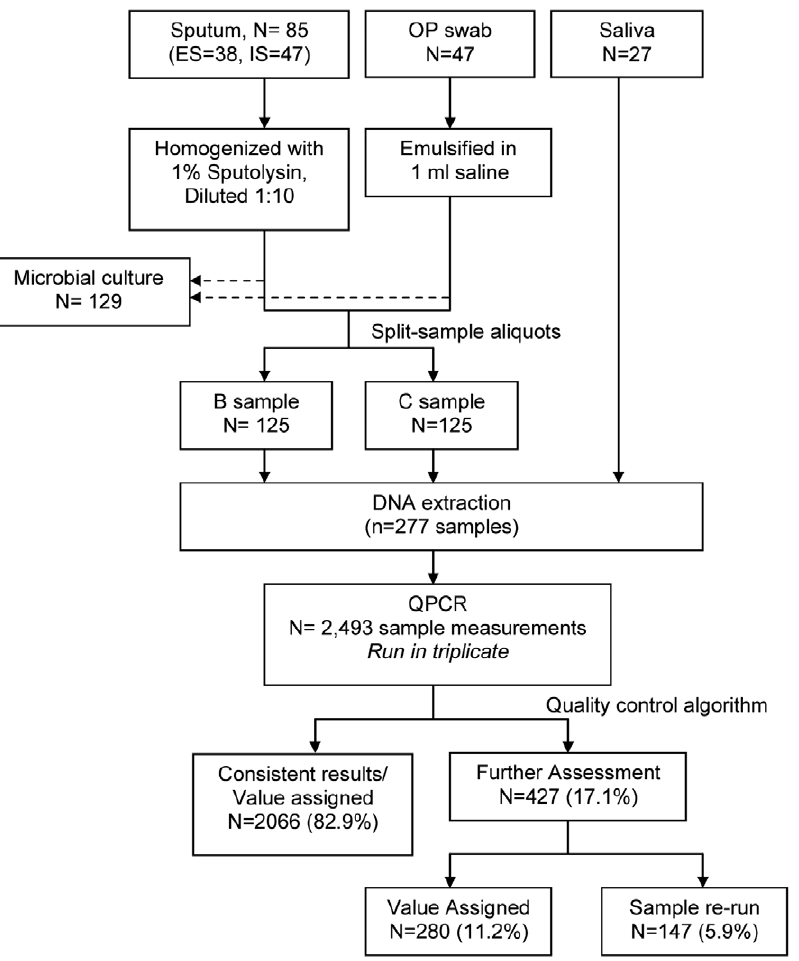
Figure 1. Specimen collection, processing, and quality control algorithm. Expectorated and induced sputa, oropharyngeal swabs and salivary specimens were collected and processed for standard CF microbial culture and/or DNA extraction (split-samples performed for sputa and oropharyngeal specimens). Bacterial load qPCR assay and eight specific organism qPCR assays were run in triplicate on all samples. Results were assessed using a quality control matrix and final value assigned to each sample. ES = expectorated sputum, IS = induced sputum, OP = oropharyngeal swab.